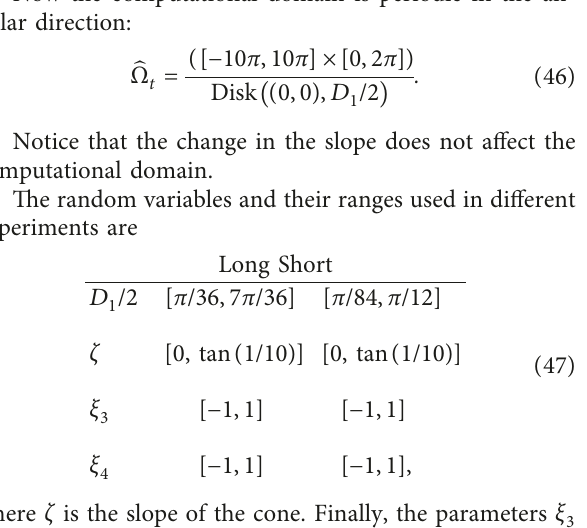
Figure 4: Cylinder-cylinder-cone schematic. The cylinder diameter R diameter of the hole D